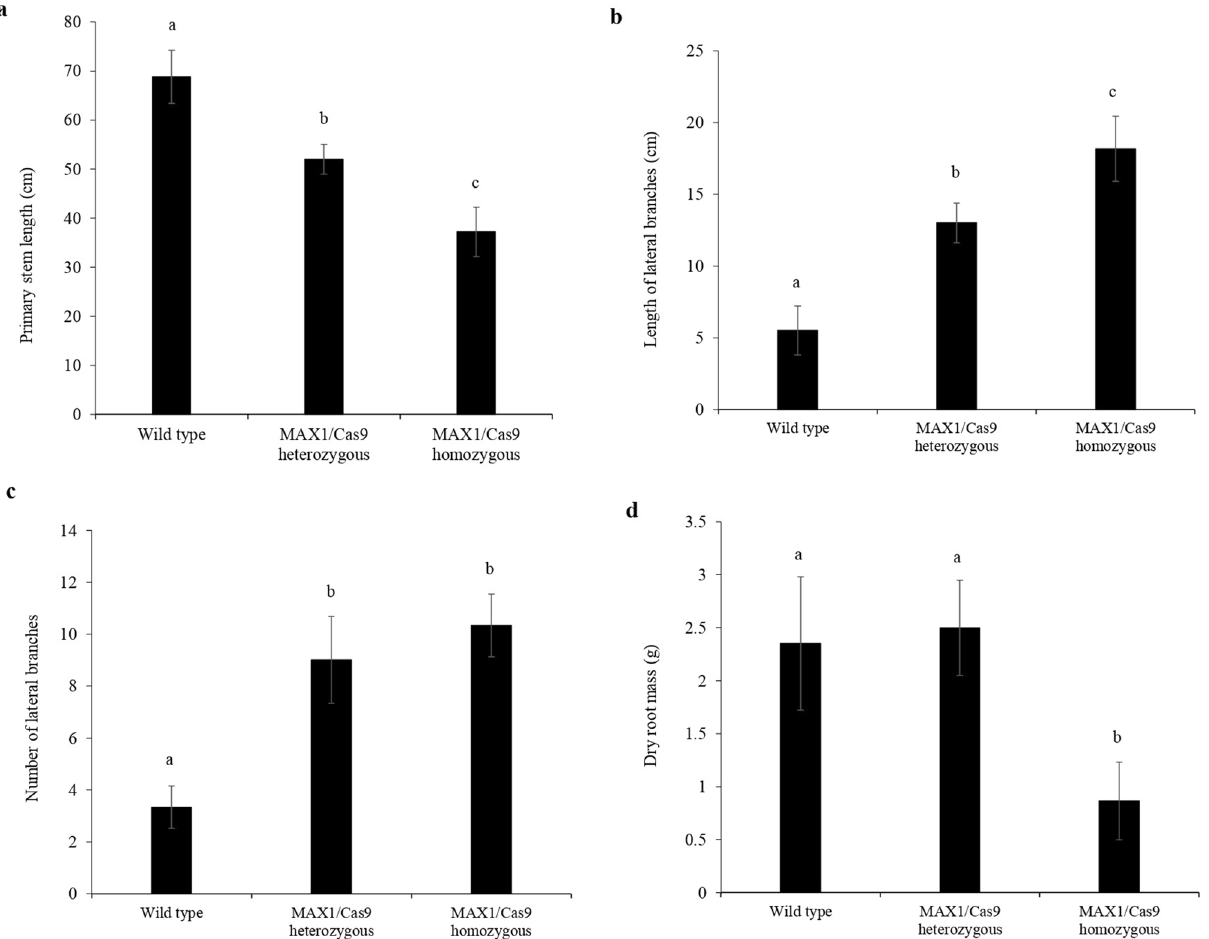
Figure 4. Quantitative analysis of morphological phenotypes in MAX1 edited lines. ( a ) Quantitative estimate of primary stem length in 1-month-old MAX1-Cas9 mutated tomato plant average ± SE. ( b ) Length of lateral branches after 1 month of growth, average ± SE. ( c ): Number of lateral branches after 1 month of growth, average ± SE. ( d ) Quantitative estimate of dry root mass of wild type and MAX1-Cas9 mutant plants after 2 months of growth. Values are the average ± SE (n = 6). (Level not connected by same letters are significant, p < 0.05; Student’s t